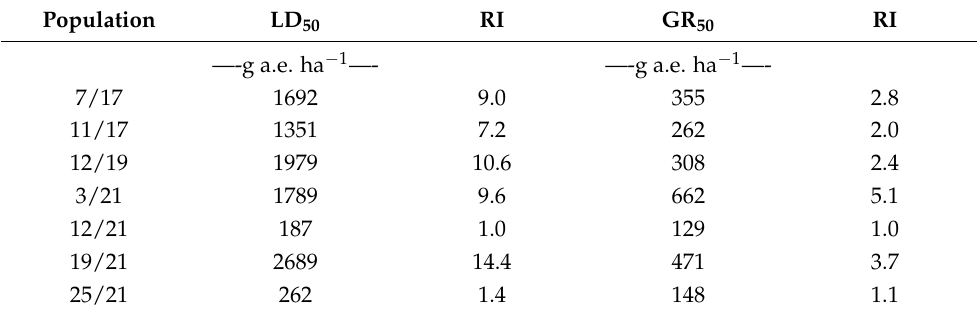
Table 2. Estimated glyphosate doses to kill 50% of the plants (LD 50 ) of seven populations of Chloris virgata , glyphosate doses required to reduce plant biomass by 50% (GR 50 ), and resistance indices (RI). Population LD